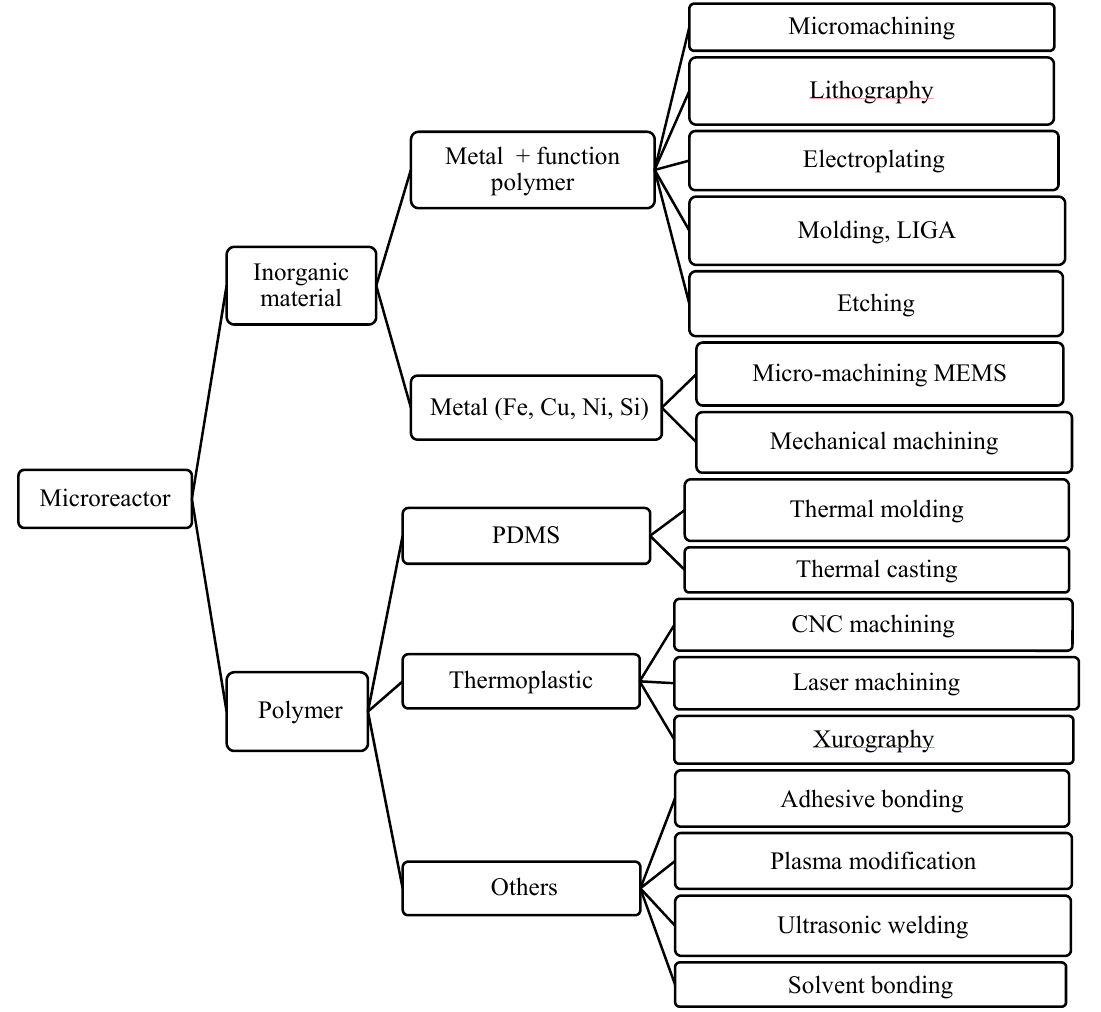
Figure 3. Materials and fabrication of microreactors.